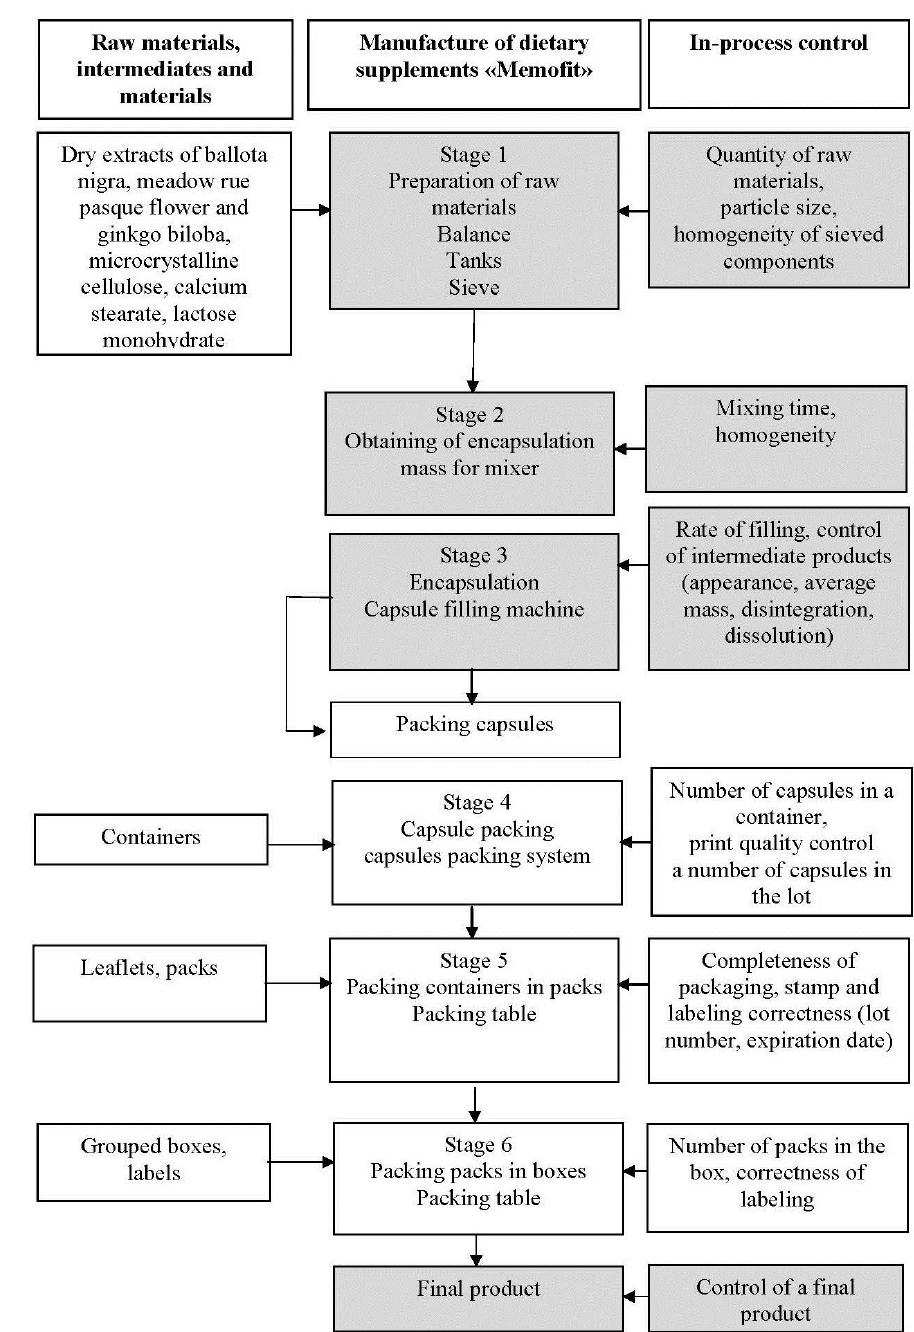
Fig. 1. Scheme of production of solid gelatinous capsules